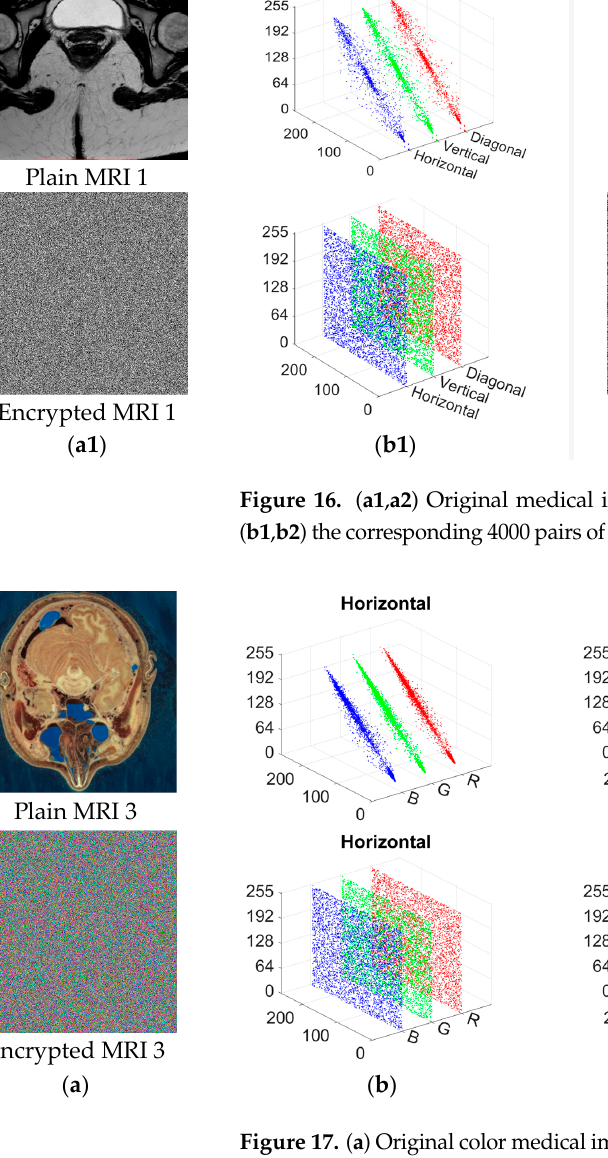
Figure 17. ( a ) Original color medical image of size 1024 × 1024 with their encrypted versions and ( b ) the corresponding pairs of 4000 adjacent pixels in the ( b ) horizontal, ( c ) vertical and ( d ) diagonal directions. Table 3. CC values in the horizontal, vertical and diagonal directions of the original medical images and their encrypted versions.